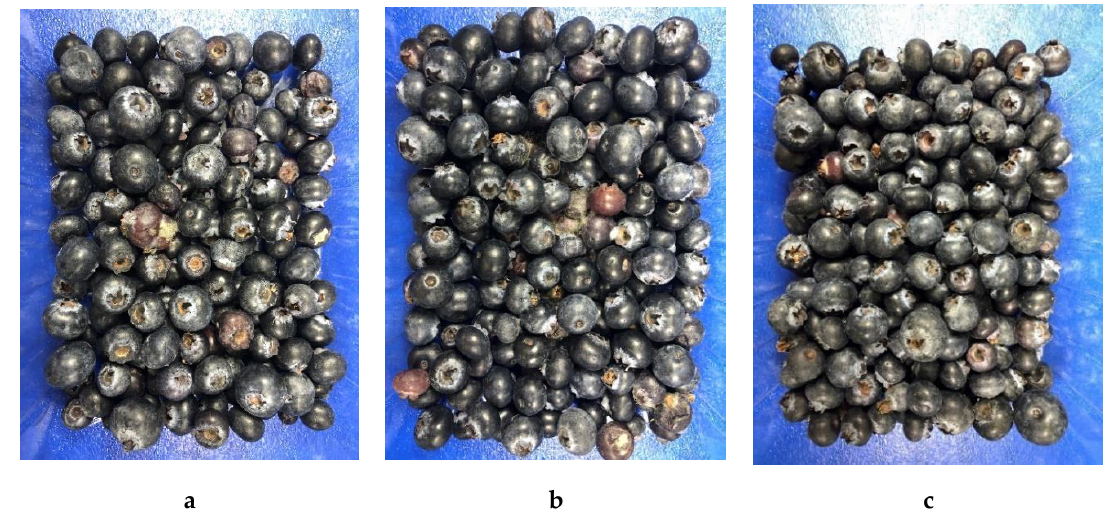
Figure 1. Effect of pectin-sodium alginate microencapsulated carvacrol ( c ) and non-encapsulated carvacrol ( b ) in comparison with control ( a ) on appearance of inoculated blueberries with C. acutatum after 10 days storage at 10 °C.